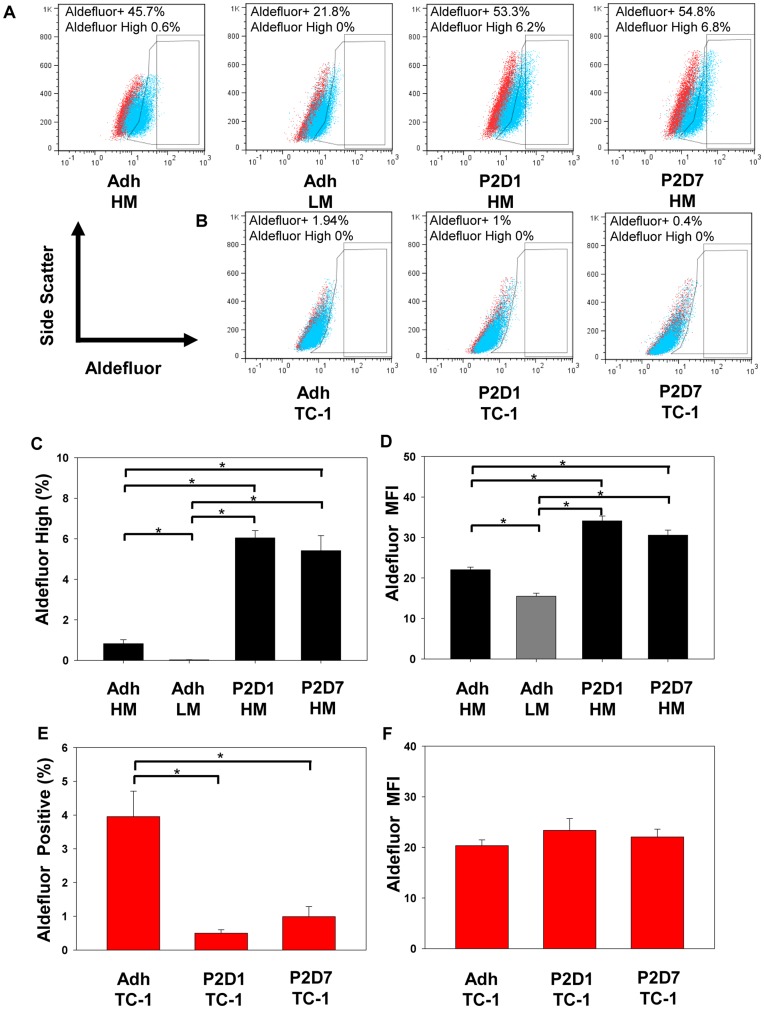
Aldefluor expression is enhanced in HM-LLC but not in TC-1 spheres compared to adherent cells.(A–B) Representative plots showing Aldefluor staining (blue) and DEAB control staining (red) for HM-LLC, LM-LLC and TC-1 adherent cells compared to passage 2, day 1 and day 7 sphere-derived cells. Aldefluor high expressing cells (rectangular box) are significantly greater in (C) frequency and (D) mean fluorescent intensity (MFI) of Aldefluor within HM-LLC spheres compared to LM-LLC or HM-LLC adherent cells, and HM-LLC adherent cells express more Aldefluor than LM-LLC adherent cells; frequency (C) *P≤0.001; MFI (D) *P≤0.002. Compared to DEAB staining, Aldefluor positivity (non-rectangular box) was found to be significantly higher in TC-1 adherent cells compared to spheres (E); *P≤0.004. MFI of Aldefluor within the TC-1 groups (F) was not found to be significantly different. No Aldefluor high population was noted for TC-1 spheres or adherent cells. Plots represent combined data from two biological repeats with three technical replicates each. Bars: ±SEM.